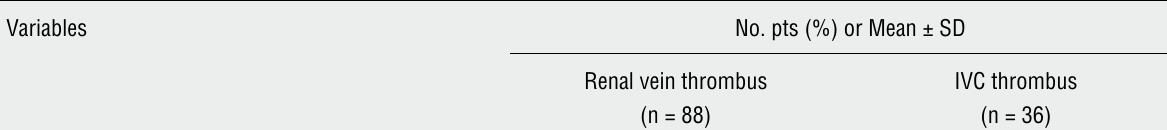
Table 1 - Baseline clinical and pathological characteristics on 124